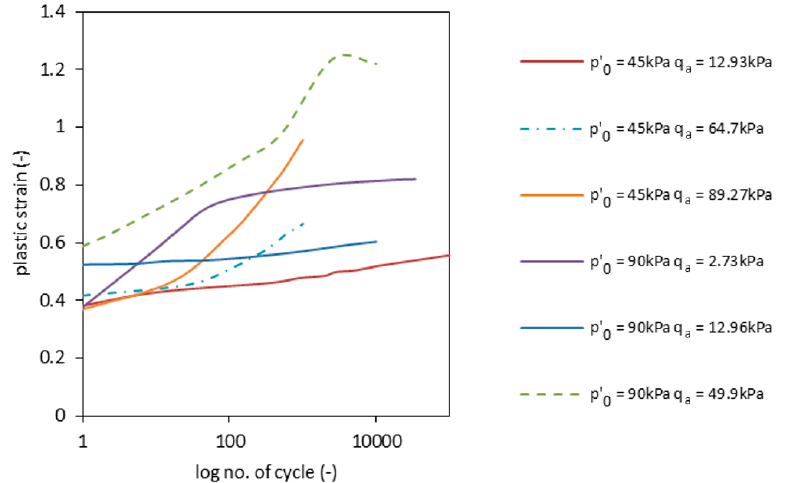
Figure 9. The accumulation of plastic strains during the three tests for the RCA sample.